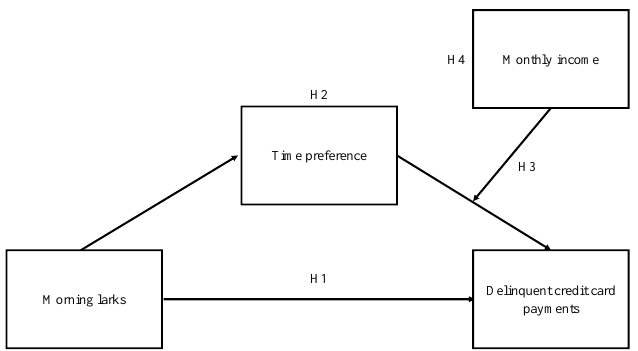
Figure 1. Illustrates the conceptual model for the relationships among morning-types, time preference, and delinquent credit card payments. The direction of the arrows indicates the hypothesized effect.